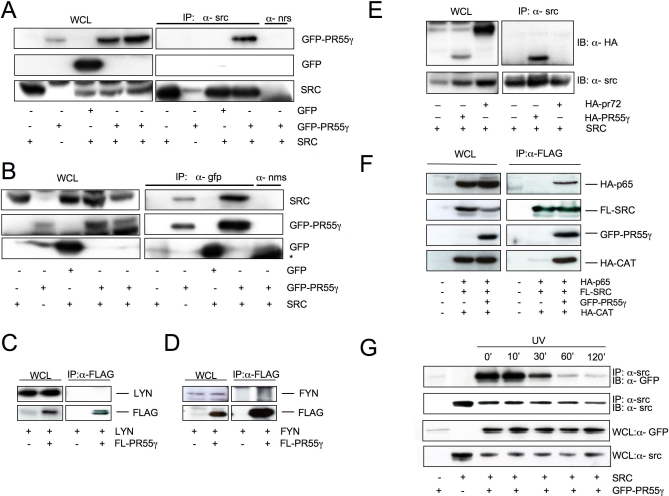
SRC Coimmunoprecipitates with PR55γ(A) U2-OS cells were transfected as indicated. At 48 h after transfection cells were lysed in ELB and c-SRC was immunoprecipitated using a polyclonal rabbit c-SRC antibody or normal rabbit serum (nrs). Coimmunoprecipitated GFP-tagged PR55γ was detected with a GFP antibody. Whole cell lysates (WCL) were probed using c-SRC or GFP antibodies to detect transfected protein.(B) Reverse immunoprecipitation as in (A) GFP was immunoprecipitated using a mouse GFP antibody or normal mouse serum (nms). Coimmunoprecipitated c-SRC was detected with a c-SRC specific antibody. The blot was subsequently reprobed with a GFP antibody to visualize the amount of immunoprecipitated GFP-tagged PR55γ protein. Whole cell lysates (WCL) were probed using c-SRC or GFP antibodies to detect transfected protein. (*) represents the light chain antibody.(C) U2-OS cells were transfected as indicated. Lysates were immunoprecipitated using a FLAG antibody. The blot was probed with a LYN specific antibody and then subsequently reprobed with a FLAG antibody to visualize the amount of immunoprecipitated FLAG-tagged PR55γ protein.(D) U2-OS cells were transfected as indicated. Lysates were immunoprecipitated using a FLAG antibody. The blot was probed with a FYN specific antibody and then subsequently reprobed with a FLAG antibody to visualize the amount of immunoprecipitated FLAG-tagged PR55γ protein.(E) U2-OS were transfected as indicated. c-SRC was immunoprecipitated using a c-SRC antibody. Coimmunoprecipitated HA-tagged PR55γ or HA-tagged PR72 was detected with a HA-specific antibody. The blot was subsequently reprobed with a c-SRC antibody to visualize the amount of immunoprecipitated c-SRC protein. Whole cell lysates (WCL) were probed using c-SRC or HA antibodies to detect transfected protein.(F) Immune precipitation of FLAG-tagged c-SRC and the PP2Ac/PR65 core dimer in HEK 293 cells in the presence (right) or absence (left) of GFP-PR55γ. The left panel shows 10% of the total lysate.(G) U2-OS cells were transfected as indicated. At 48 h after transfection cells were treated with UV (100 J/ m2) and incubated for a further 10, 30, 60, and 120 min, respectively. Equal amounts of cell lysate (500 μg) were immunoprecipitated with α- c-SRC antibody. Coimmunoprecipitated GFP-tagged PR55γ was detected with a GFP specific antibody. The blot was subsequently reprobed with a c-SRC antibody to visualize the amount of immunoprecipitated c-SRC protein. Whole cell lysates (WCL) were probed using c-SRC or GFP antibodies to detect transfected protein.doi:10.1371/journal.pgen.0030218.g005